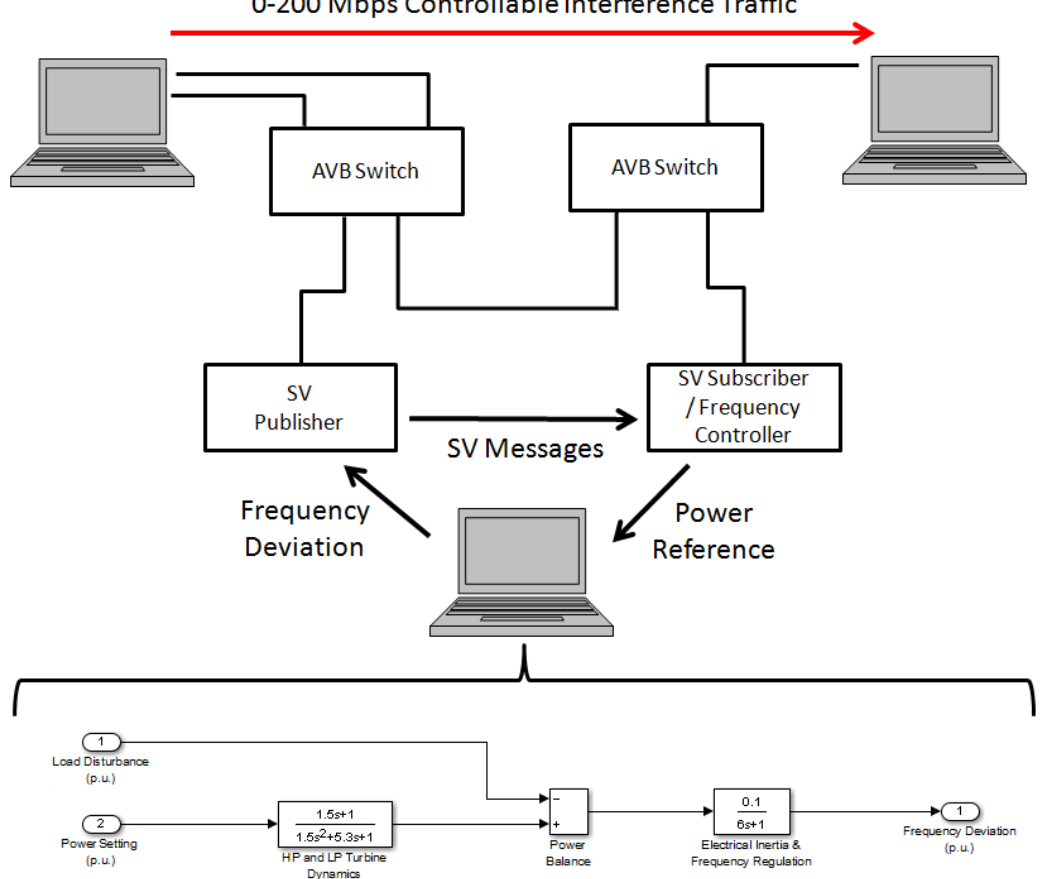
Figure 8. Schematic of experiment two configuration.